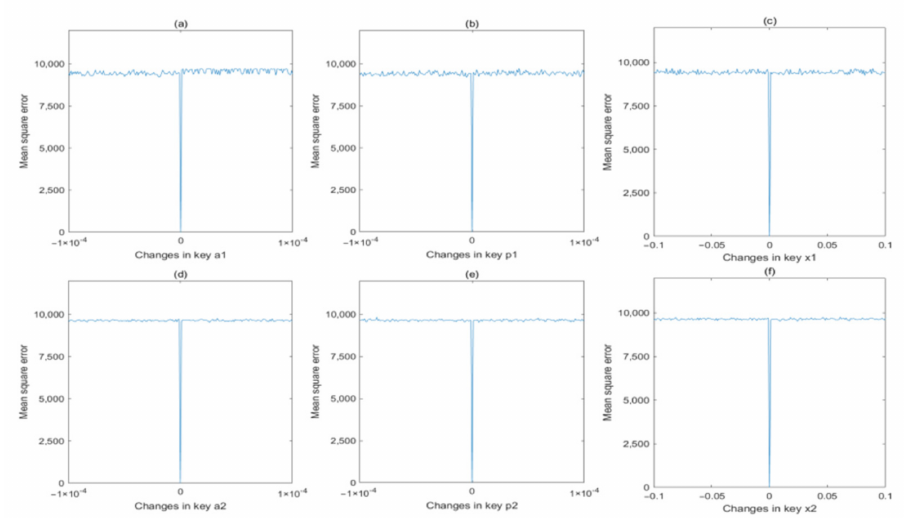
Figure 15. MSE analysis in decryption process for different keys: ( a ) a1; ( b ) p1; ( c ) x1; ( d ) a2; ( e ) p2; ( f )